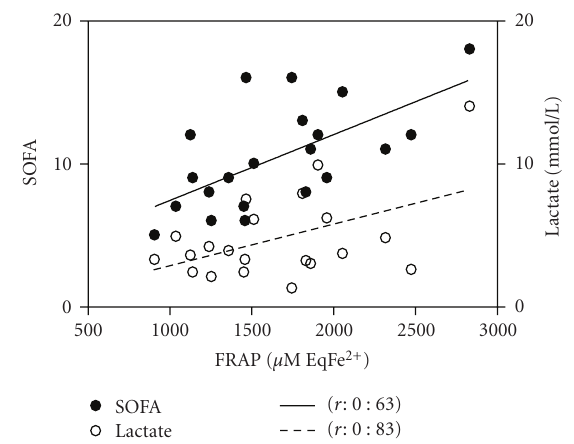
Figure 4: Admission correlations of peak SOFA score and peak lactate levels with peak FRAP levels. P < . 05 for the correlation exposed.